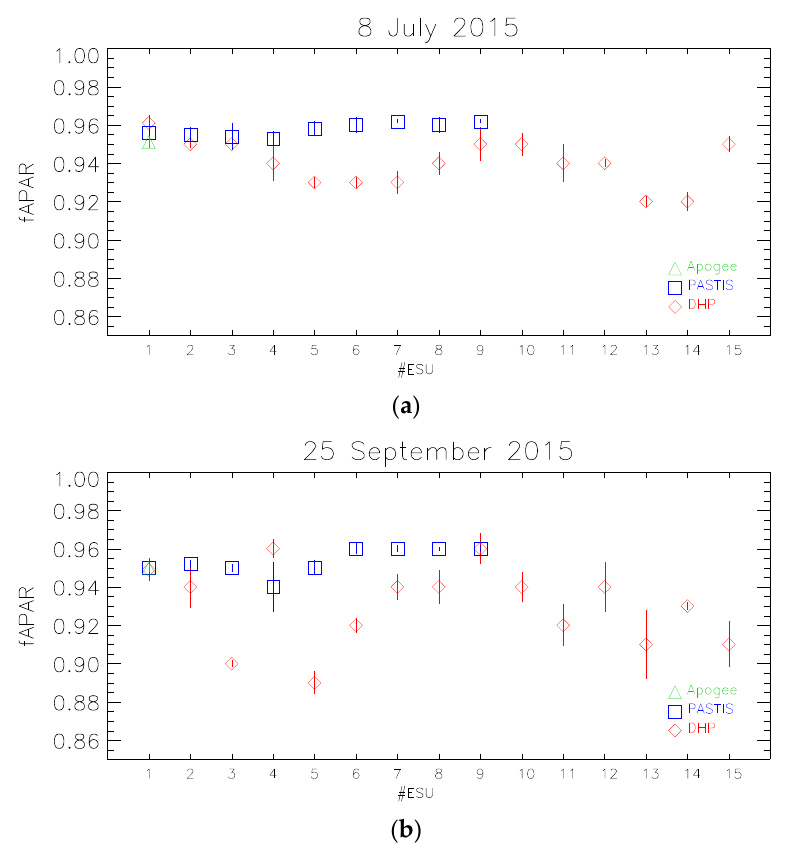
Figure 6. Spatial variation of fAPAR APOGEE , fAPAR PASTIS and fAPAR DHP values distributed by ESUs on 8 July 2015 ( a ) and 25 September 2015 ( b ). Error bars are expressed as standard deviation.